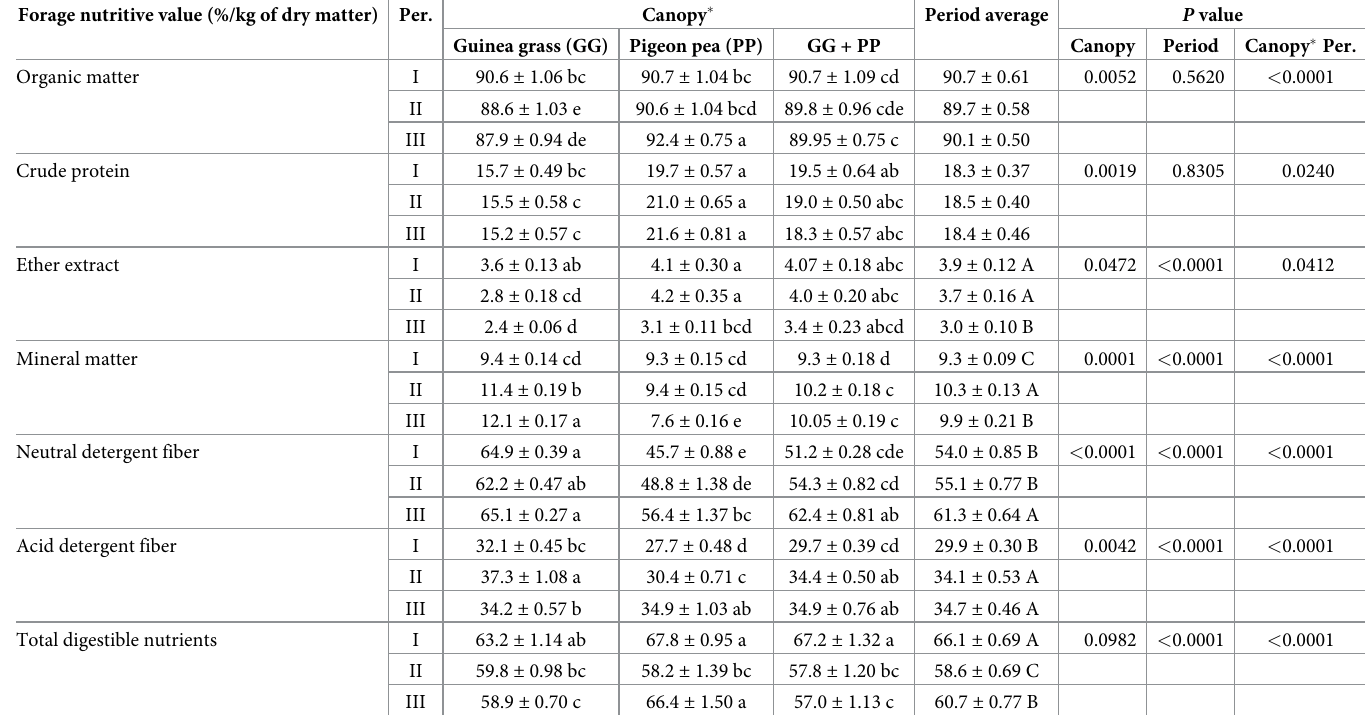
Table 1. Qualitative characteristics of different tropical pastures available to grazing young lambs in southern Brazil. Forage nutritive value (%/kg of dry matter)